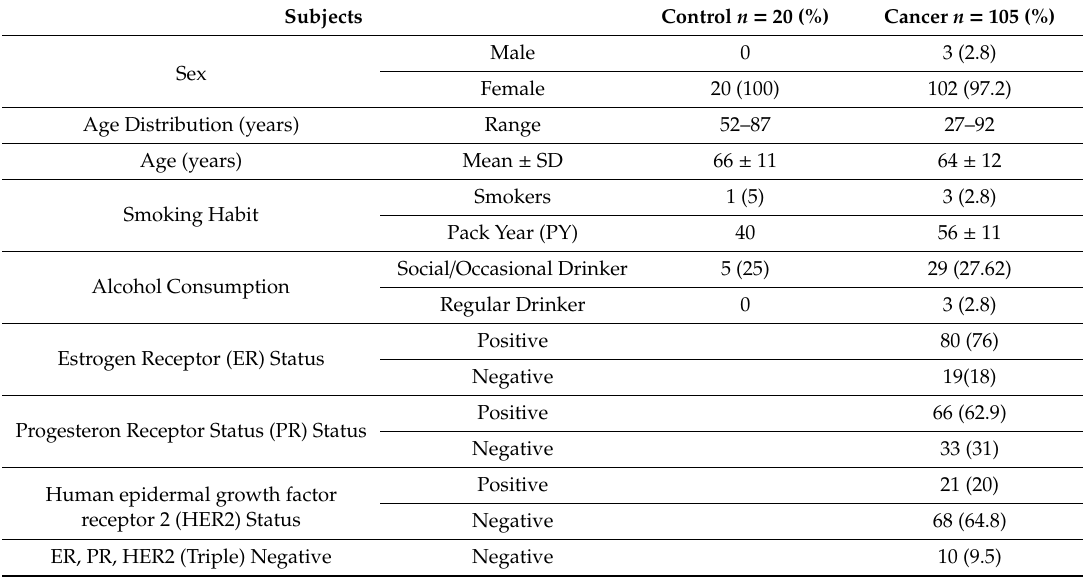
Table 1. Demography, tobacco exposures, tumour grade, and hormone status of the control and tumor samples used in this study. Patient demography of human tissue biopsy samples illustrated. Samples were age matched; majority of the sample members are female. Also, alcohol consumption, tobacco exposure, and hormone receptor status were quantified, none was significantly di ff erent. Sample description has been published previously